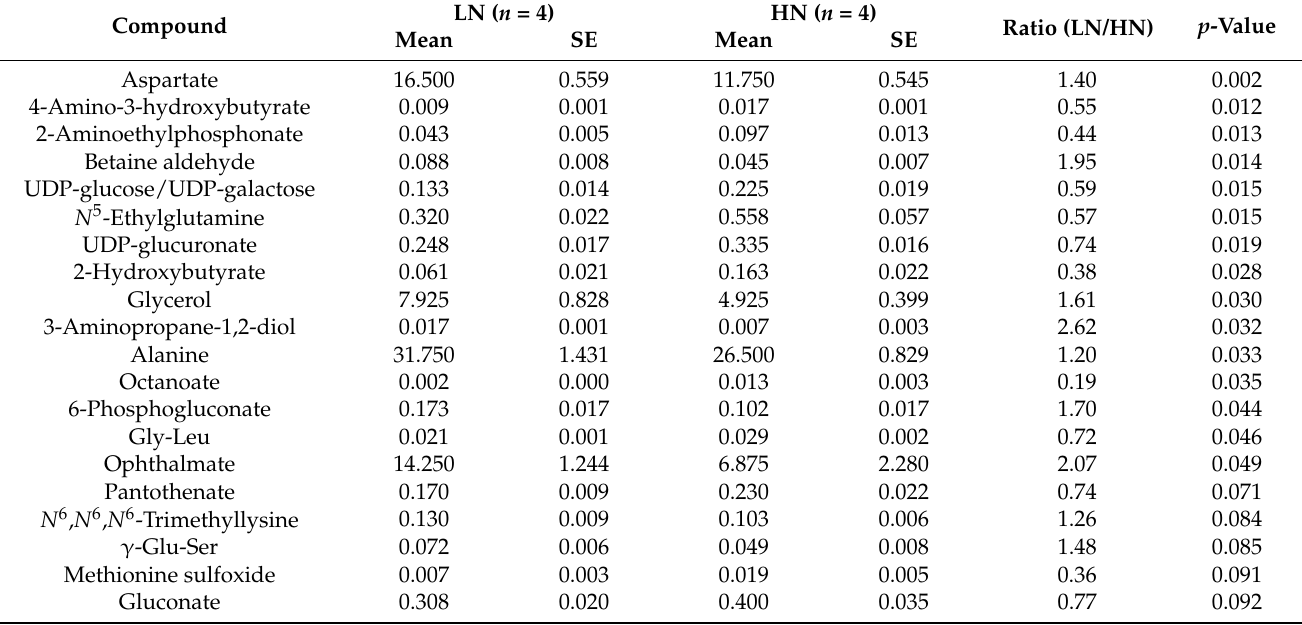
* Values in table are relative content levels (arbitrary